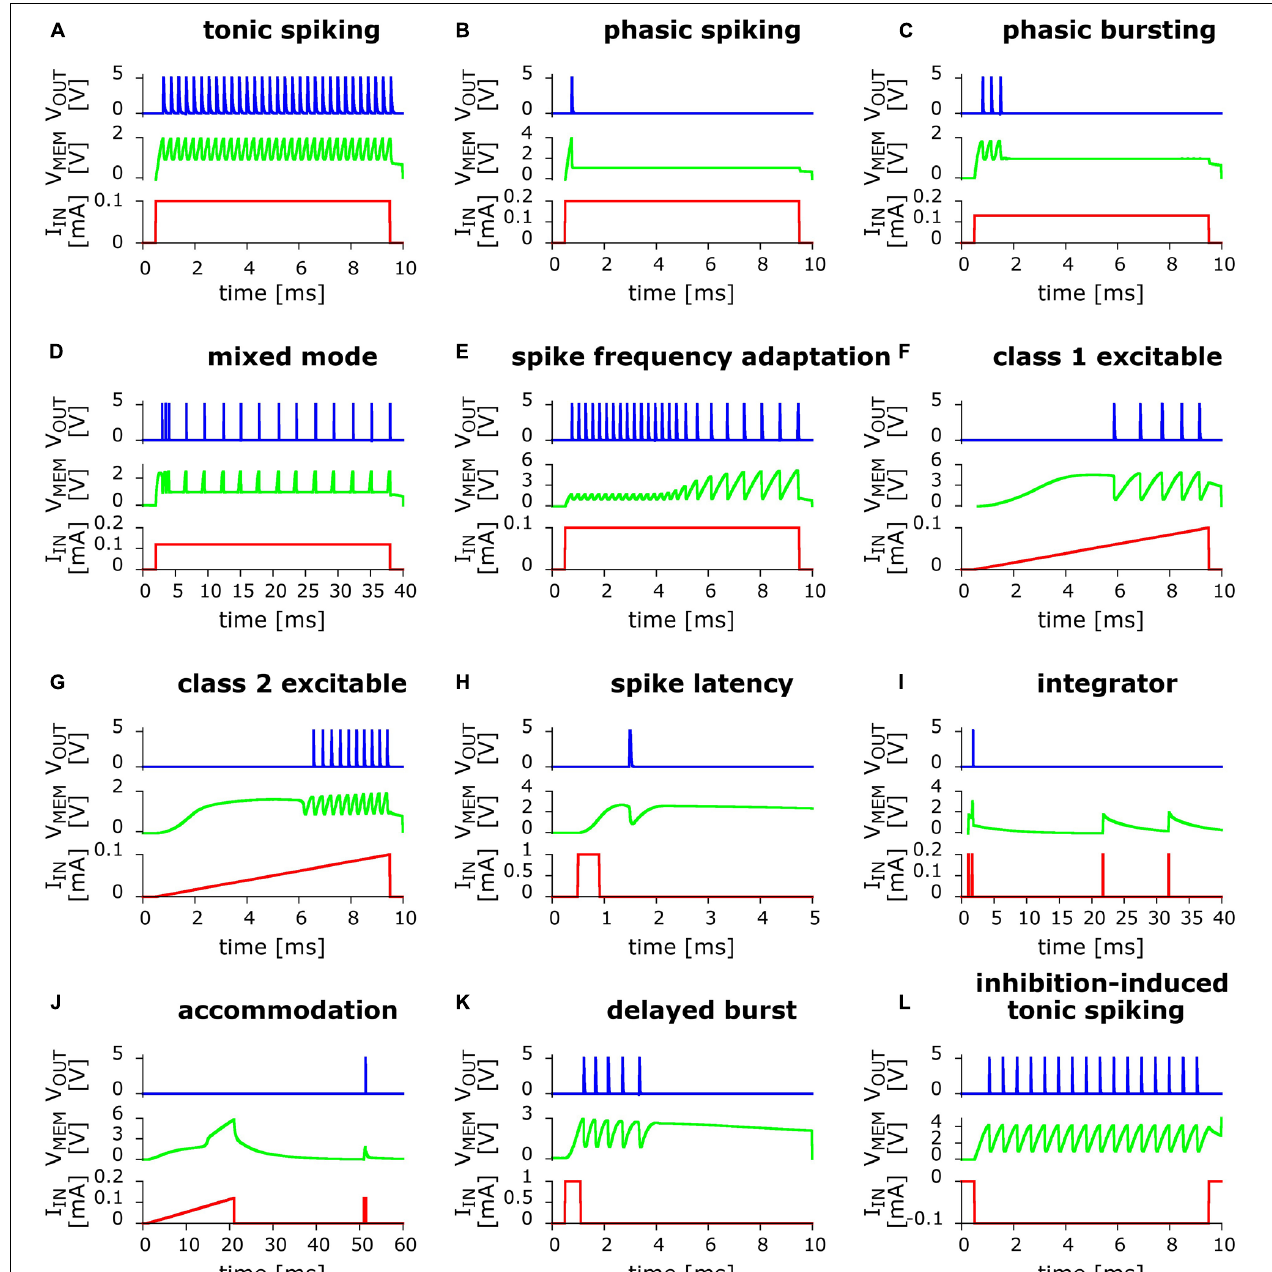
FIGURE 4 | Twelve biologically relevant behaviors measured in small variants of the basic UCN circuit. In red line is the applied input current excitation I IN as function of time. In green line is the “membrane” capacitor voltage V MEM . In blue line is the output voltage V OUT that shows the dynamical spiking behavior. From left to right and top to bottom: (A) Tonic spiking; (B) phasic spiking; (C) phasic bursting; (D) mixed (burst then spiking); (E) spike frequency adaptation; (F) class 1 excitable; (G) class 2 excitable; (H) spike latency; (I) integrator; (J) accommodation; (K) delayed burst (note: this behavior is biologically plausible but not among the Izhikevich set); and (L) inhibition-induced (negative polarity input) tonic spiking (note: the “rebound spike” behavior can be trivially obtained from this one via a shorter time input). Further details on the measured circuits along with the values of their components are described in the Supplementary Material